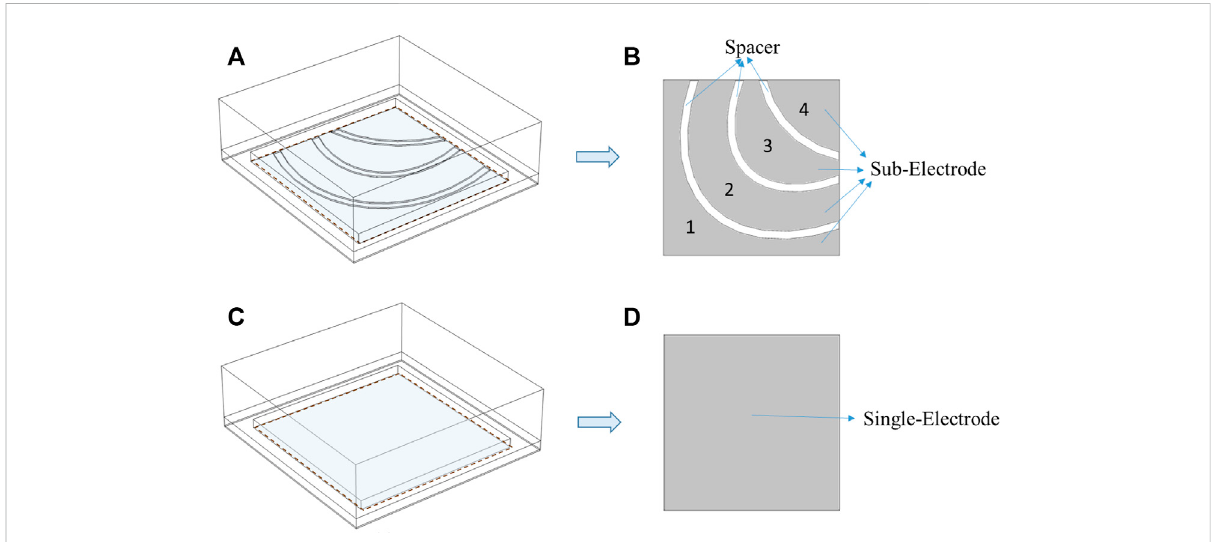
FIGURE 3 Arcmulti-electrodeand single-electrode pixelstructure. (A) An arcmulti-electrodepixel structure. (B) The arcmulti-electrodecontains 4sub- electrodes and 3 spacers. The width of all spacers was 6 μ m. (C) A single-electrode pixel structure. (D) A